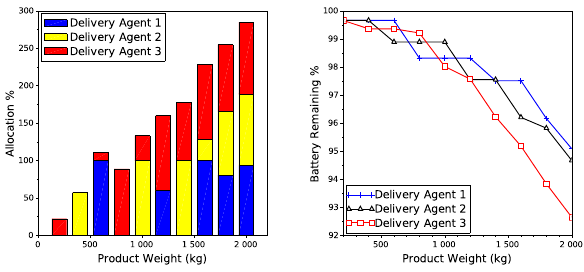
Figure 8. Allocation Ratio to Agents, Battery Degrada- tion.